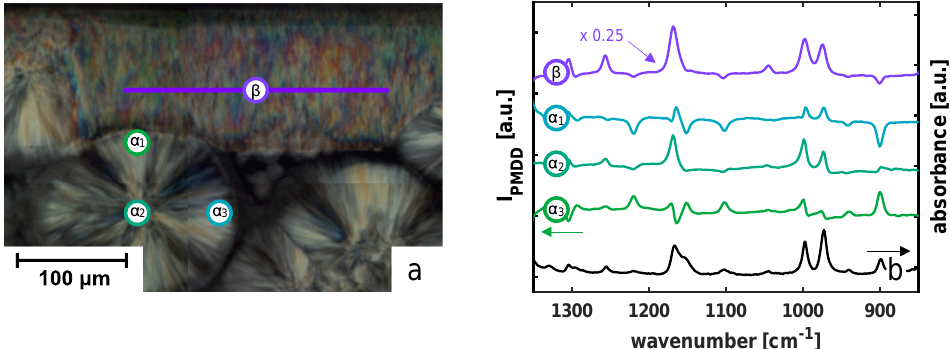
Figure 2. ( a ) Polarized optical micrograph of a representative morphology close the fiber–matrix interphase. ( b ) PMDD spectra taken at different positions in the semi-crystalline morphology, showing several spectral bands that are sensitive to vibrational linear dichroism. The locations where the PMDD spectra were measured are indicated by the markers in ( a ). A conventional FTIR absorbance spectrum of iPP is provided as a